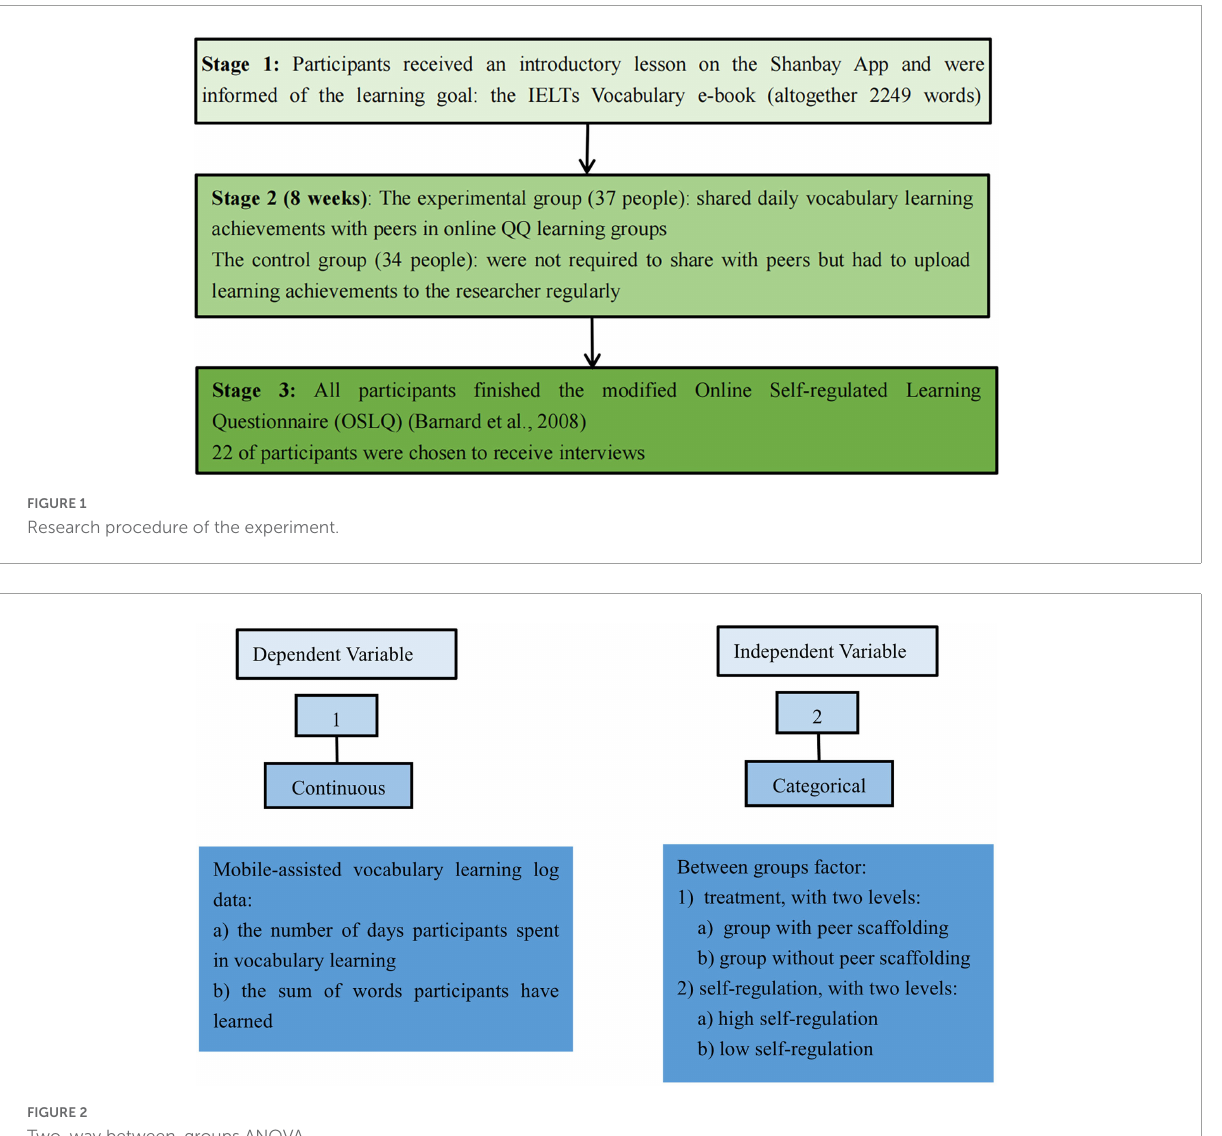
FIGURE2 Two-way between-groups